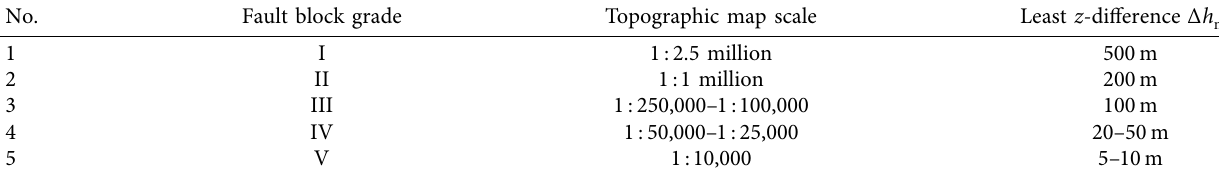
Table 2: Empirical value of minimum elevation difference in fault structure division.